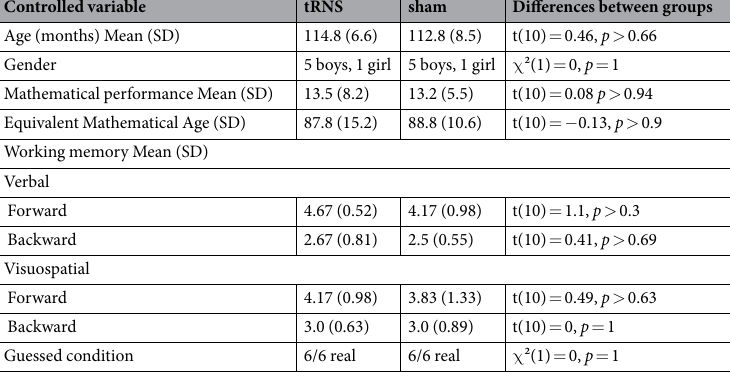
Table 1. Children with MLD were matched across groups (sham vs. tRNS) by their age, gender, mathematical abilities, and working memory capacity. While MALT provided the equivalent mathematical age based on raw scores, it did not provide a standardised score below a certain level of performance. Therefore, we presented the raw scores and the mathematical age equivalence. Working memory capacity is represented by standard